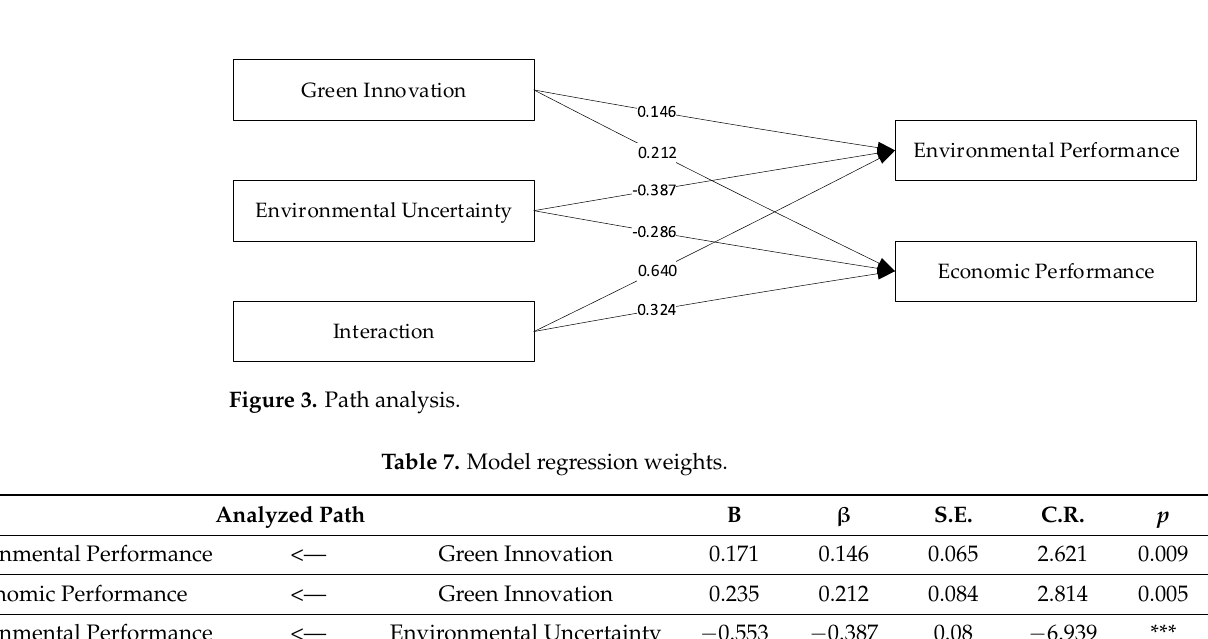
12 of 19 Figure 2. Structural equation model. Table 5. SEM model fit indices. Variable